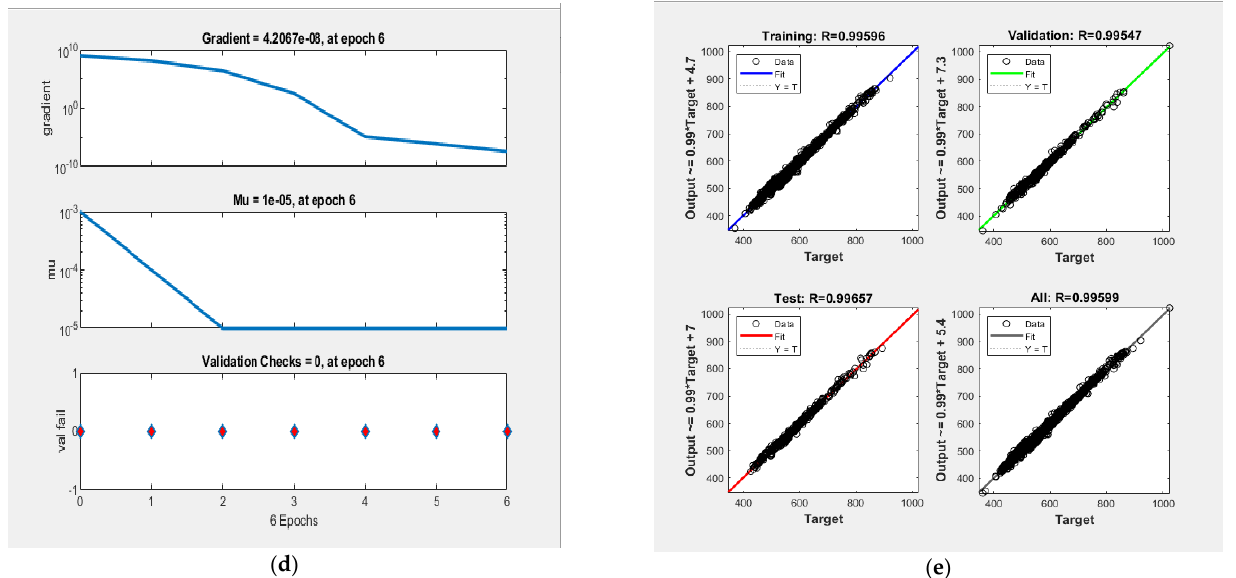
Figure 7. ANN Model in MATLAB for Dehradun and surrounding regions: ( a ) Model Architecture; ( b ) Model Parameters, ( c ) Model training performance, ( d ) Training state of Model and ( e ) Regression plots for target vs. output values.